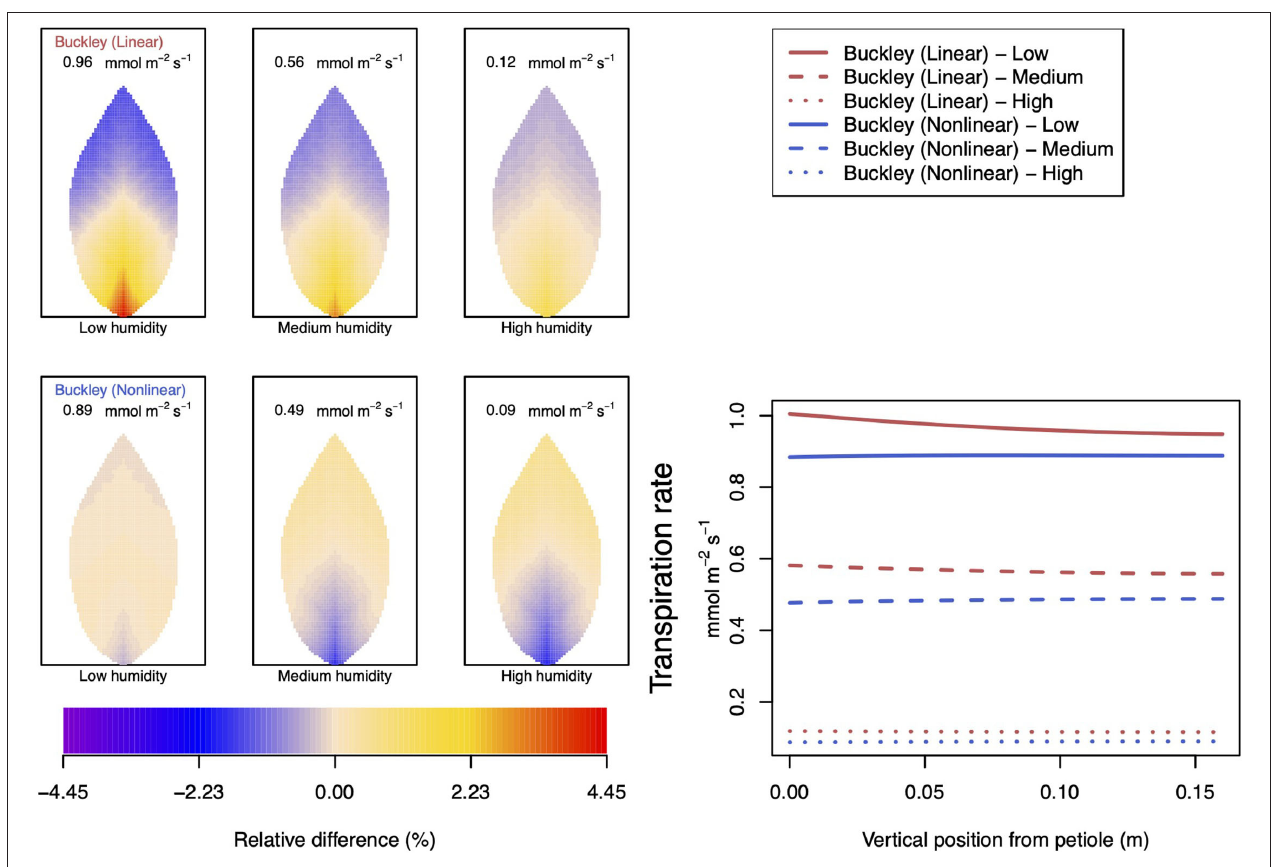
FIGURE 12 | A comparison of model predictions of transpiration rates ( − F T ) distributed over the leaf for different values of relative humidity . Details as in Figure 8 , except for a temperature of 10 ◦ C (283.15 K) . In this case, the uniform/leaf-area average predictions using the Leuning (1995) stomatal model are 1.03, 0.69, and 0.18 mmol m − 2 s − 1 under low, medium, and high humidity, respectively (2D heat maps are not shown). Note that the transpiration rates are represented as − F T for easy